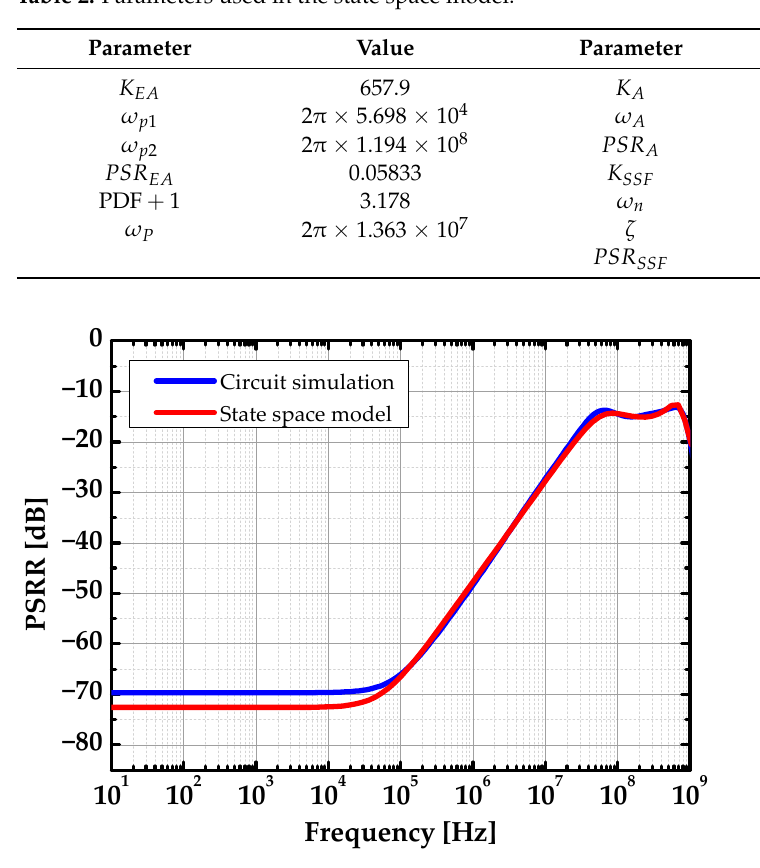
Figure 7. PSRR of the proposed LDO. Table 2. Parameters used in the state space model.